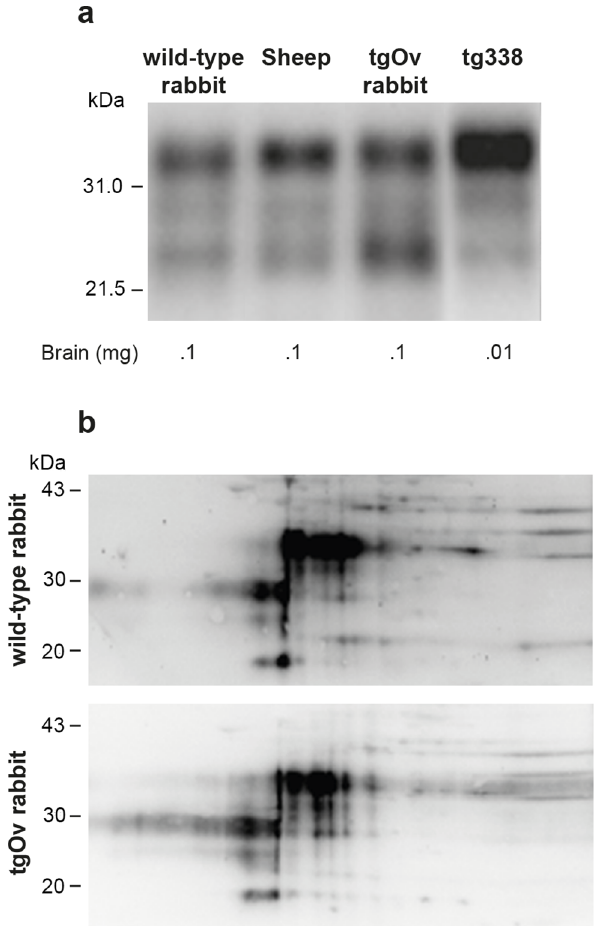
tg338 mice. The amounts of material loaded are indicated. (b) Two-dimensional electrophoretic gel analysis of PrP C from wild-type and tgOv rabbit. The equivalent of 1mg of brain extract was used for comparison (Acidic side at left). Blots were probed with Sha31 anti-PrP